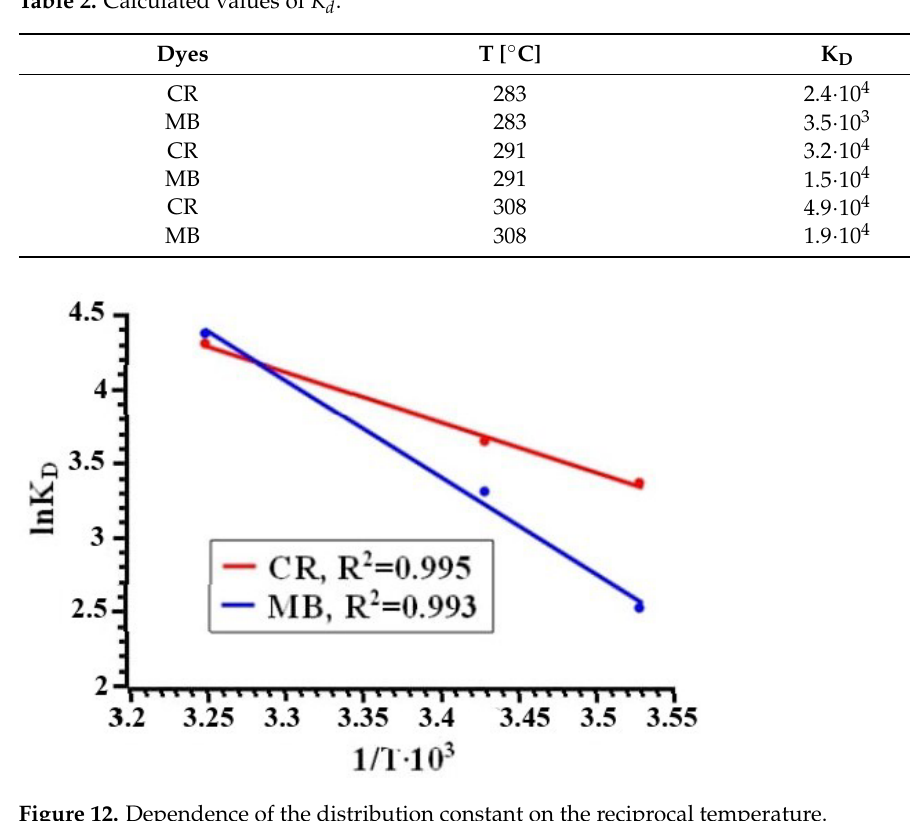
Table 2. Calculated values of K D .